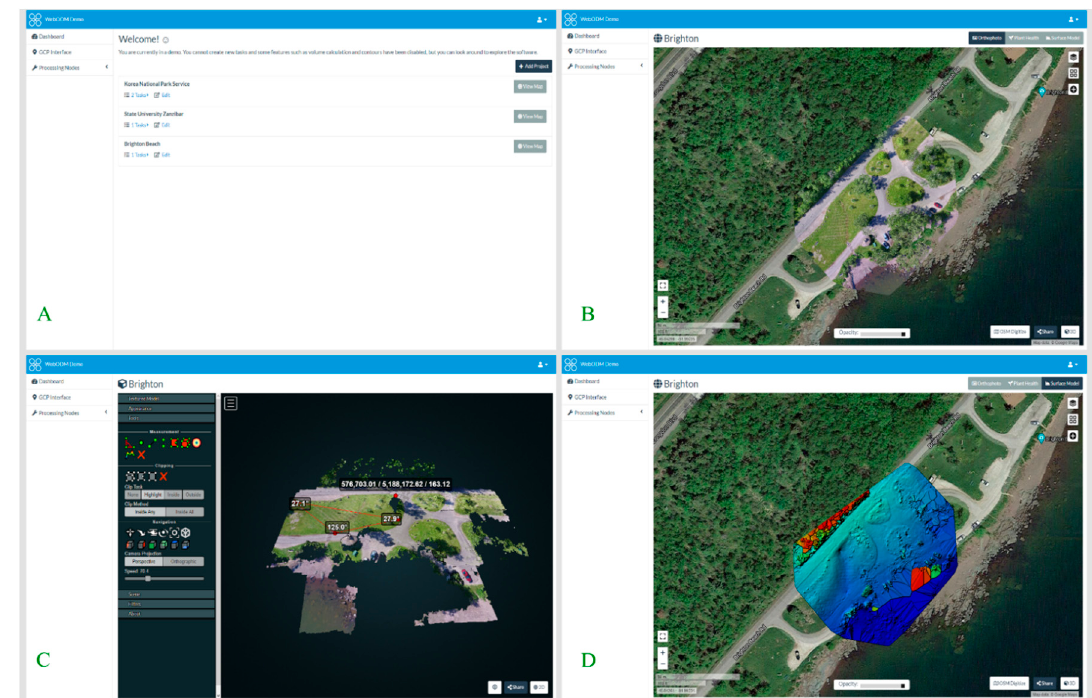
Figure 4. Screenshots of interface of open source image processing software WebODM (demo version). ( A ) Represents the user interface ( B ) Orthophoto of a certain area of Brighten beach can be distinguished ( C ) Represents the 3D model of the terrain ( D ) Represents a DSM for a certain area of Brighten beach [34] .